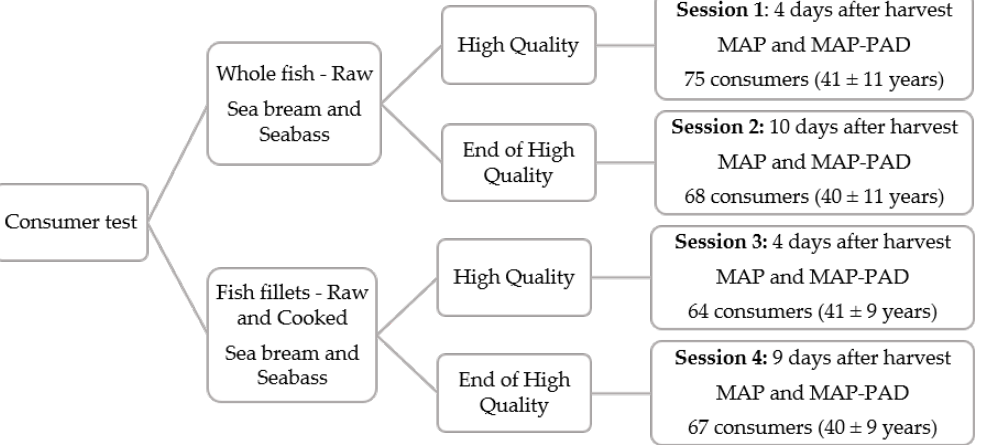
Figure 1. Schematic overview of the consumer test experimental design. MAP: modified atmosphere packaging, MAP-PAD: modified atmosphere packaging with CO2-emmiting pad.